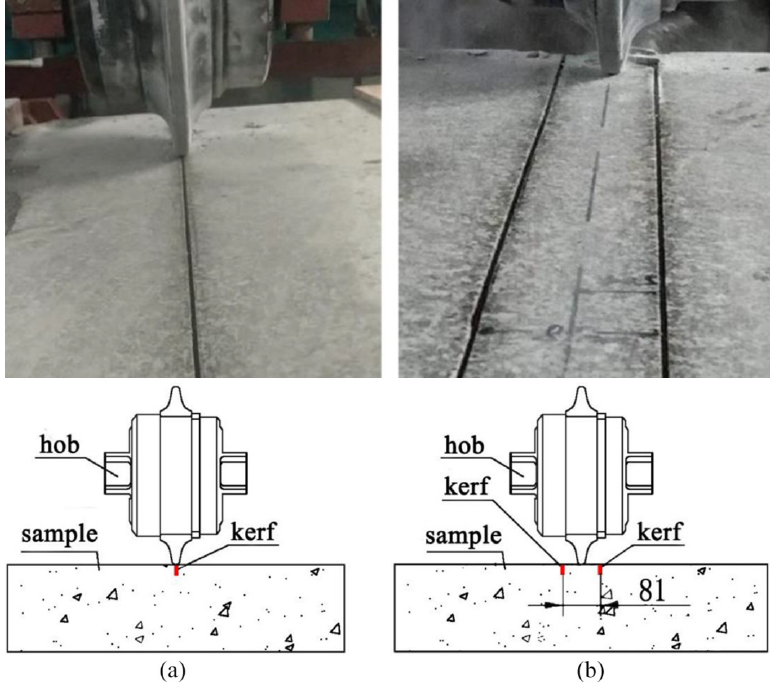
Figure 9. View and diagram of slots cut in relation to the disk tool during the mining tests at the laboratory stand: ( a ) slot along the disk axis, ( b ) two slots on the sides of the disk [21].